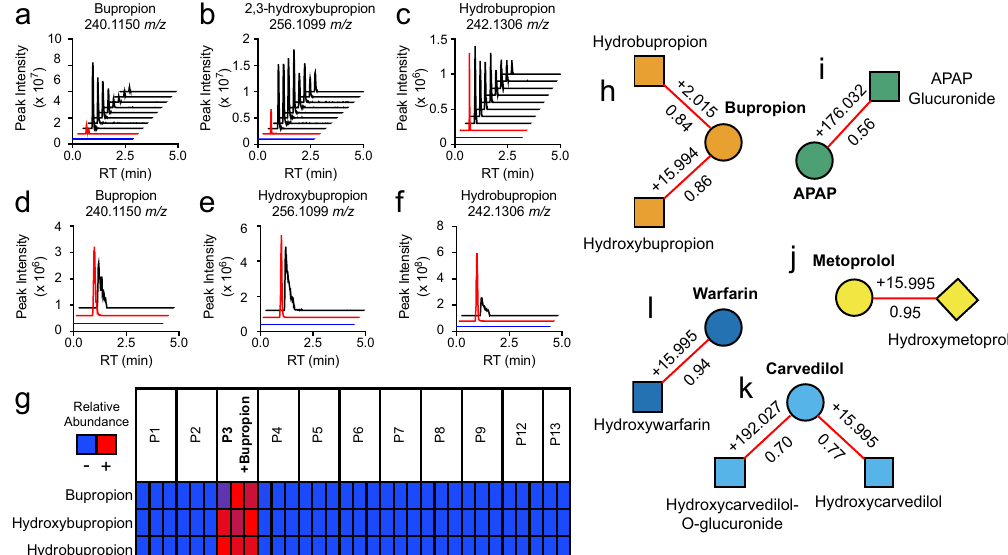
Fig. 5 Identi fi cation of documented xenobiotic exposures. Extracted ion chromatograms of blood pharmacokinetic data from mice (black) that received bupropion show a – c bupropion, hydroxybupropion, and hydrobupropion are detected at the same accurate mass m / z and retention time as S9-enzyme generated metabolites (red). These metabolites were not detected in a control sample (blue). Extracted ion chromatograms of plasma collected from an individual (black) taking bupropion shows d – f bupropion, hydroxybupropion, and hydrobupropion are detected at the same accurate mass m/z and retention time as enzyme-generated metabolites (red). g Co-occurrence of bupropion with its expected metabolites only in the samples with documented bupropion use. Relative abundance values were colored across each row using the maximum observed peak intensities (red) and minimum observed peak intensities (blue) for a particular metabolite. h – k Pathway-level biotransformation networking of parent xenobiotics shows expected metabolites with characteristic mass shifts (above red edge) are correlated (Partial least squares regression R value shown below red edge) with parent